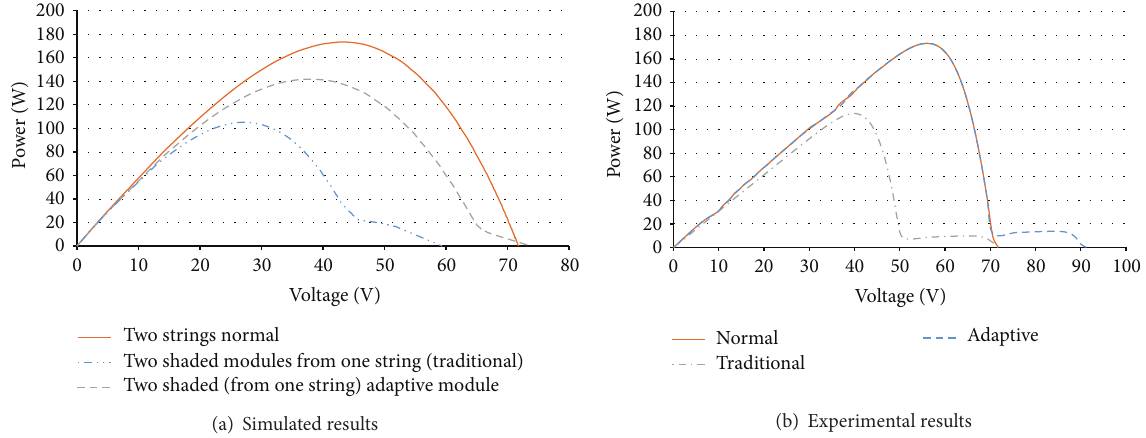
Figure 8: Simulation and experimental results for traditional and proposed adaptive system with two shaded